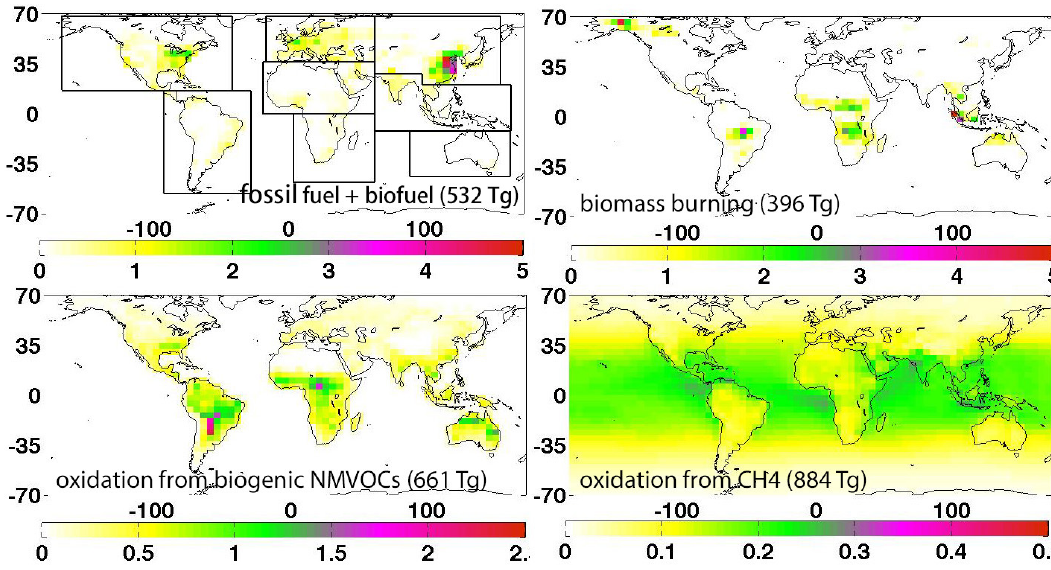
Figure 1. Annual mean CO emissions from combustion sources and the oxidation of biogenic NMVOC and CH 4 , averaged from June 2004 to May 2005. The unit is 10 12 moleccm − 2 s − 1 . The continental domains are defined with black boxes. The sub-continental domains in North America (US, Mexico, Alaska and Canada) are separated based on the country